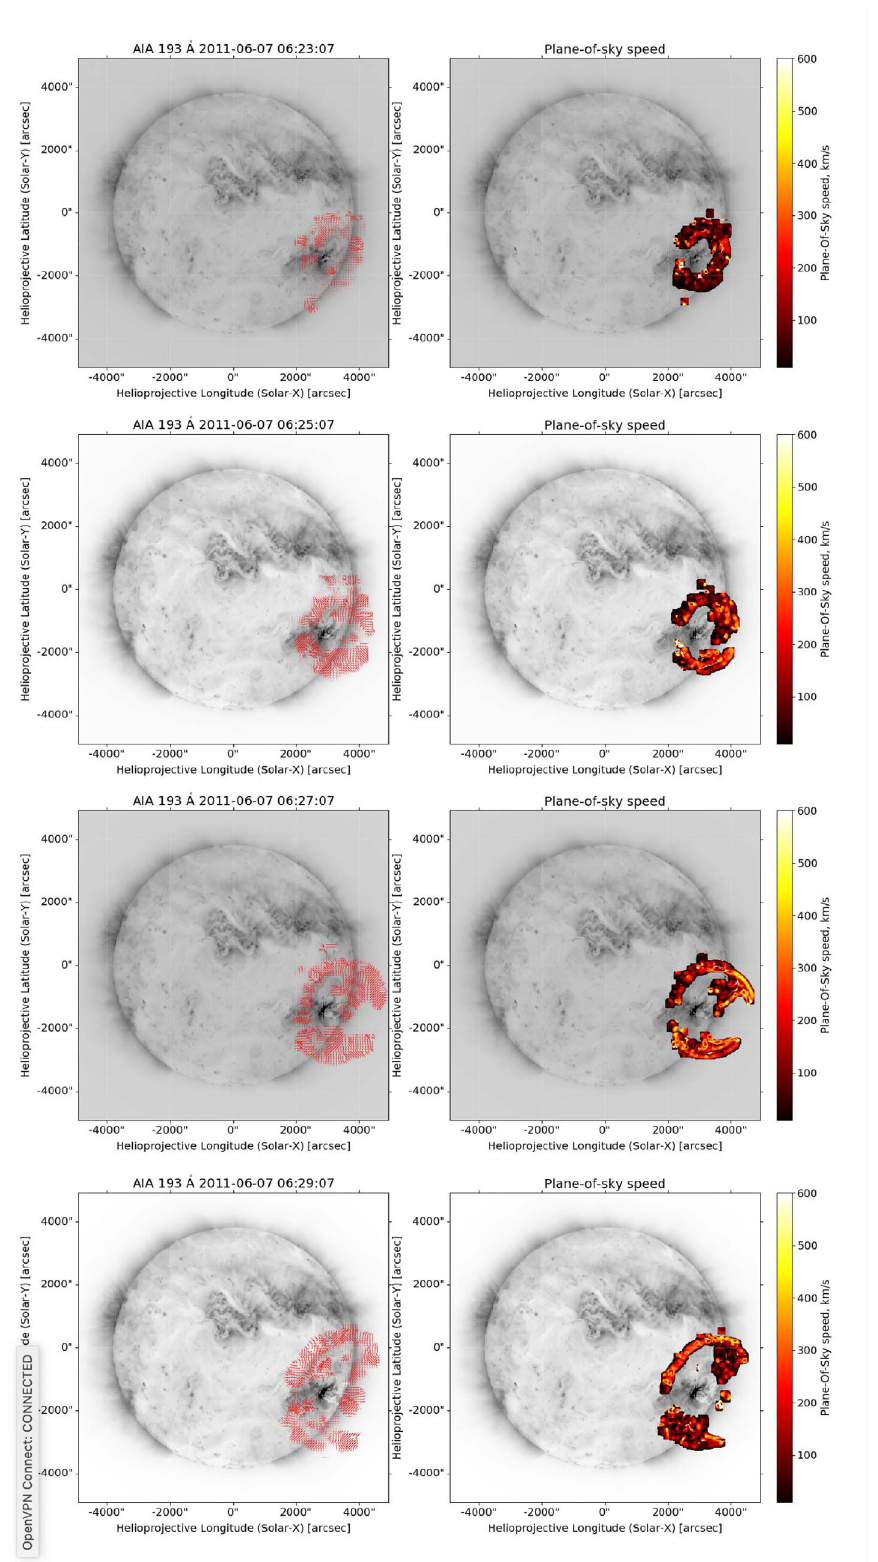
Fig. 10. The output of the FLCT model for the June 07, 2011 event, for the four pairs of consecutive images is shown in Figure 9. Left panels: Arrows showing the plane-of-sky velocity. Right panels: The plane-of-sky